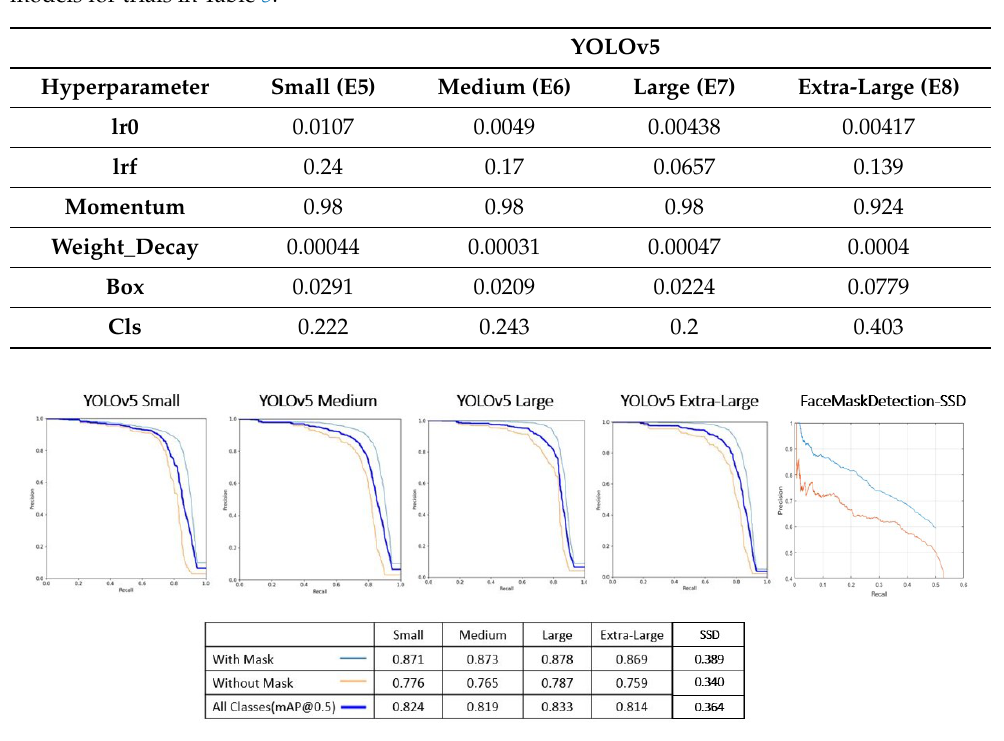
Figure 9. Presentation of Precision-Recall curves of models. In legend of each model, you can see average accuracies obtained for each